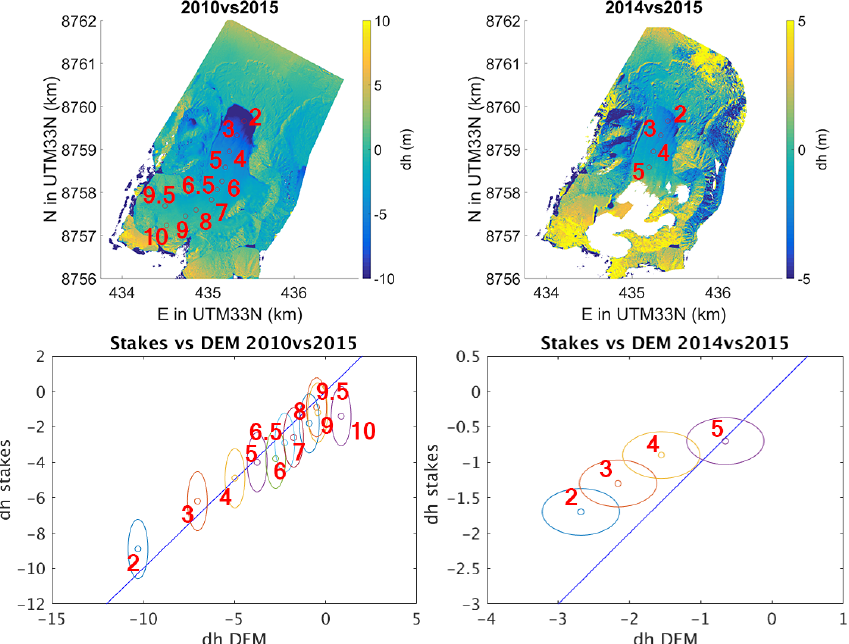
Figure 13. Top: position of mass balance stakes overlayed on the DEM difference for 2010–2015 (left) and 2014–2015 (right). Bottom: height variation at the stake positions according to the DEMs ( x axis) versus according to the stake measurements ( y